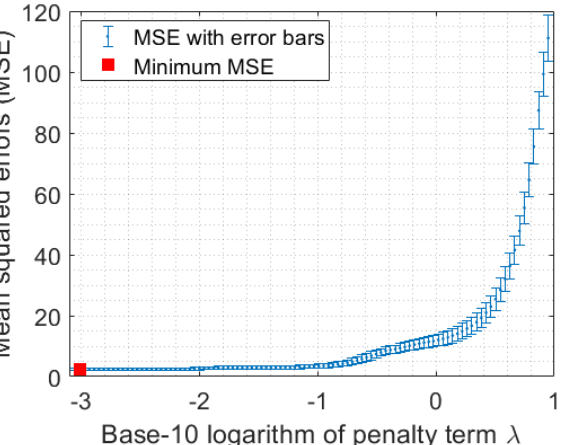
Figure 8. The mean square errors obtained by the k -fold cross-validation algorithm given the different penalty term λ